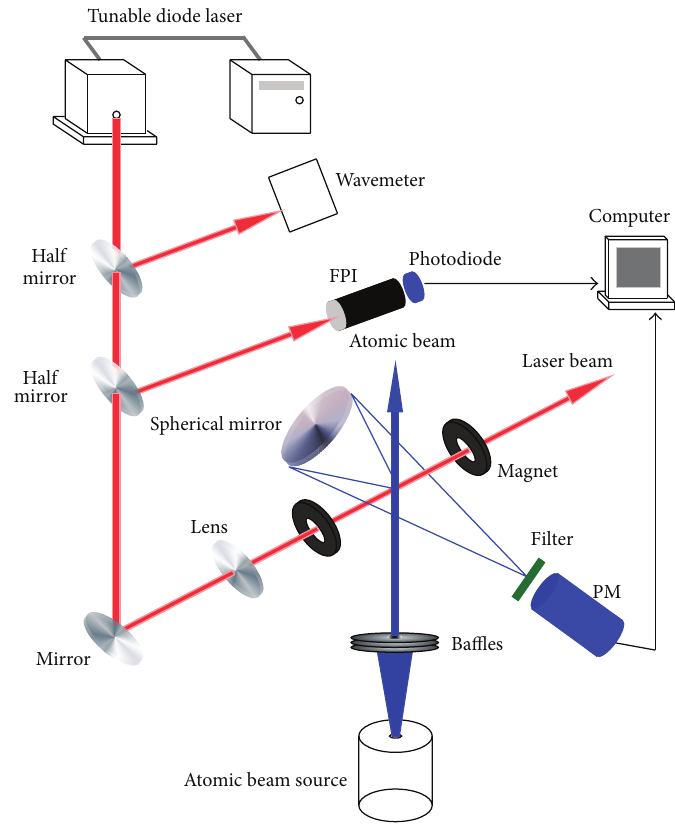
Figure 1: Experimental setup. FPI denotes Fabry-Perot interferometer and PM